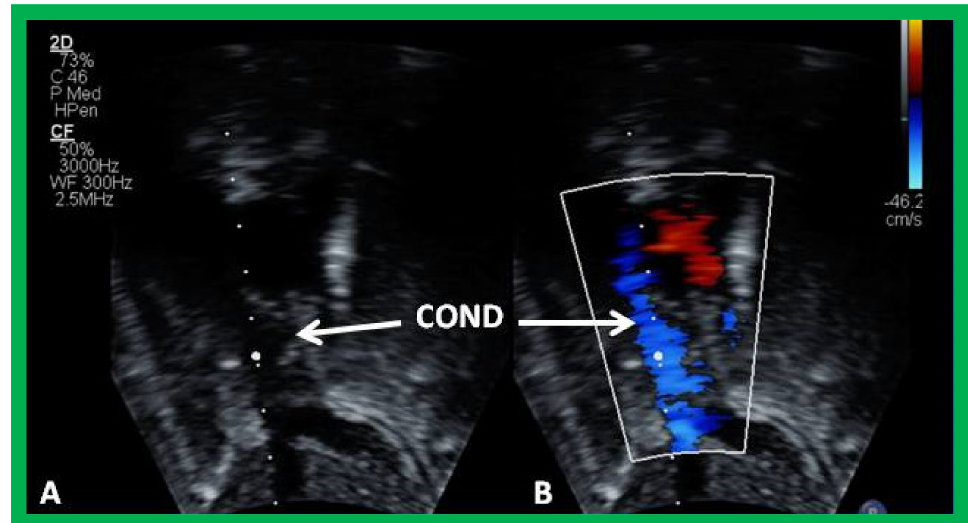
Figure 15. Echo images illustrating widely open conduit (COND) by 2D ( A ) and color flow imaging ( B ). Note laminar flow in B which suggests a lack of obstruction in the COND. Reproduced from Reference [26].